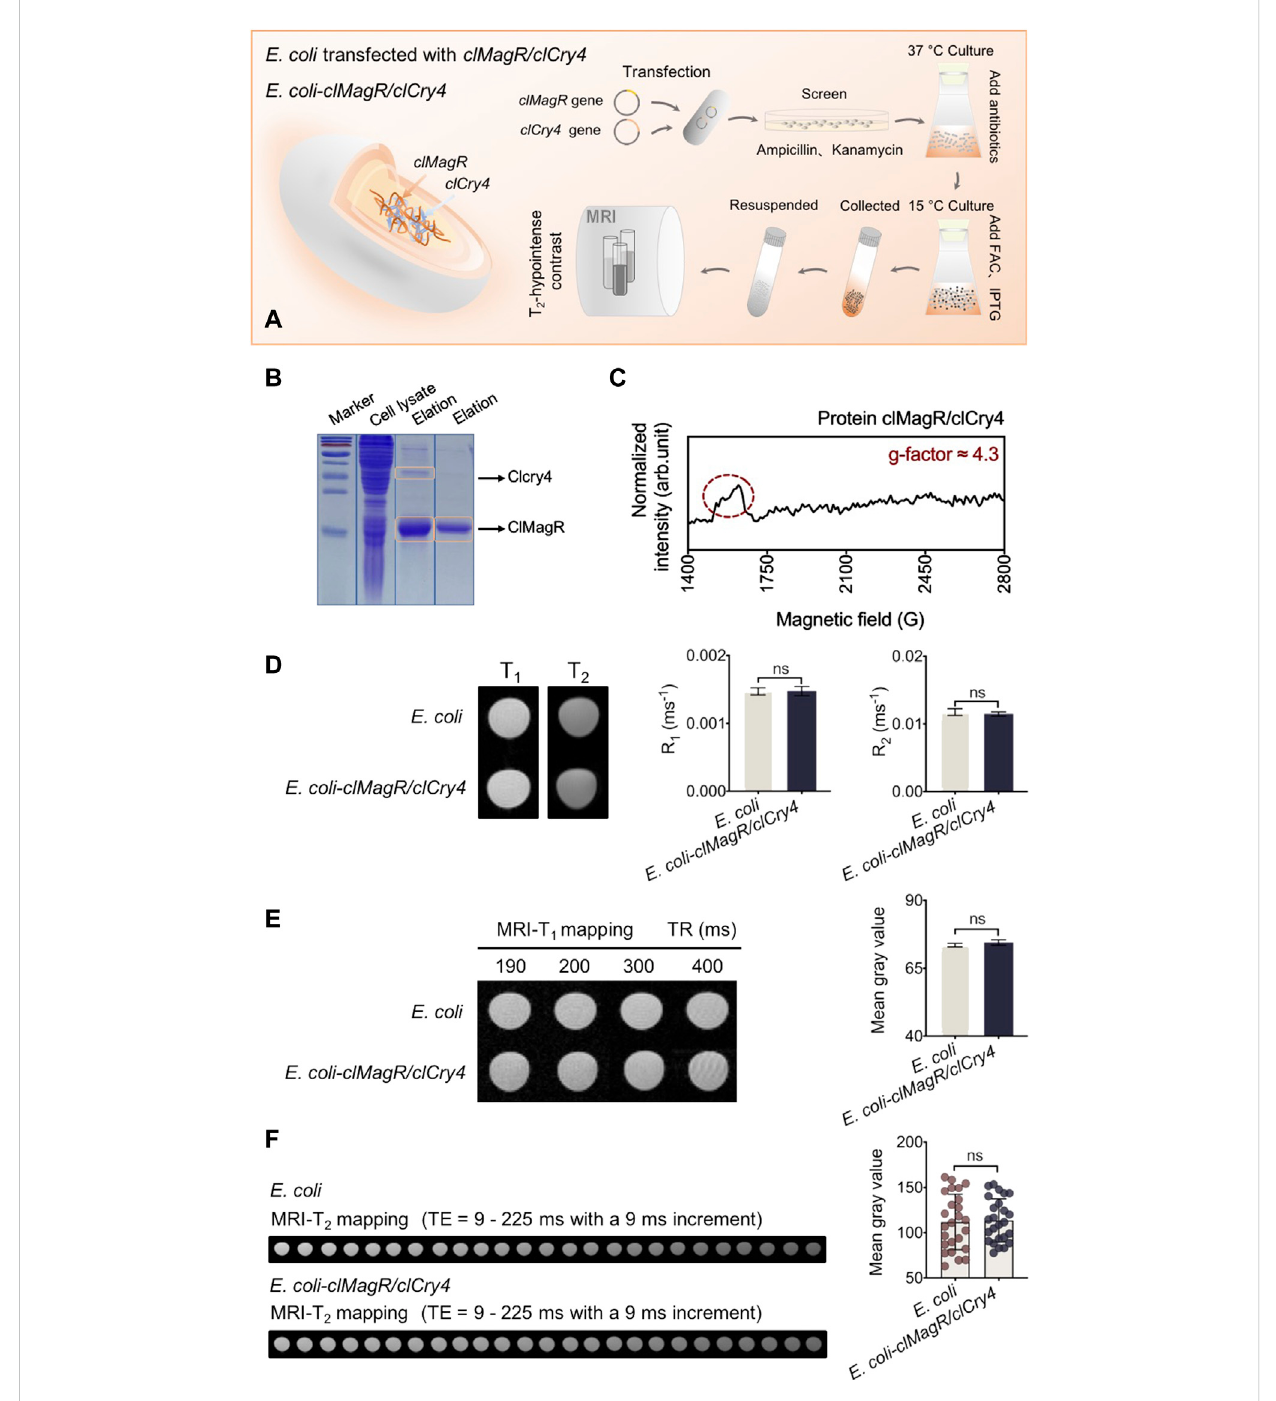
FIGURE 1 Bacteria construction and MRI analysis. (A) Schematic illustration of the prokaryotic expression system and bacterial culture. clMagR/clCry4 is transfected into a commonly used bacterial model (as heterologous host), the E. coli BL21 (DE3) strain to investigate MRI susceptibility. (B) SDS-PAGE analysis. Arrows point to clMagR and clCry4. PageRuler prestained protein ladder was used to indicate the apparent molecular mass standards (marker, kDa). (C) ESR spectrum of the clMagR/clCry4 protein. Signal at g ’ ≈ 4.3 in spectrum attributed to protein-Fe(III) complex. (D) MRI-T 1 and -T 2 images show the signal intensity of E. coli . Histograms represent bacterial R 1 and R 2 statistical values. (E) Bacterial MRI-T 1 mapping and the corresponding mean gray values analysis. (F) Bacterial MRI-T 2 mapping and the corresponding mean gray values analysis. It should be noted that the bacterial densities of samples were almost equivalent (A600 units/mL, OD 50.0). Data were presented as mean ± SD ( n = 3). For MRI R 1 and R 2 values, statistical differences were analyzed using the unpaired Student ’ s t-test. For the mean gray value data, statistical signi fi cances were analyzed using two-way ANOVA followed by the Bonferroni and Tukey ’ s HSD post-hoc test. ns, no signi fi cance ( p >